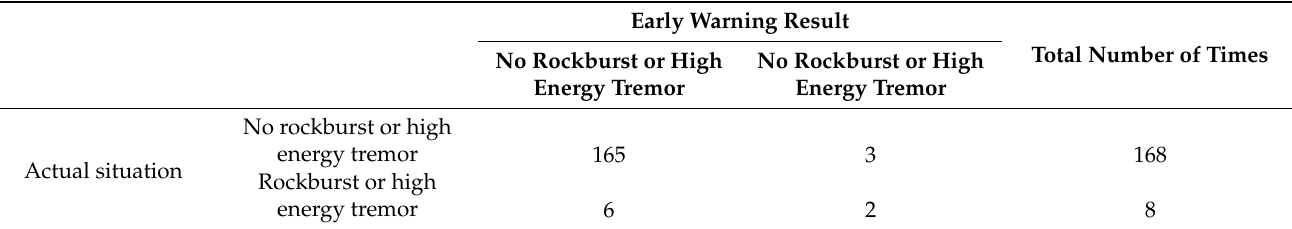
Table 5. Early warning effectiveness test results of “critical value” early warning